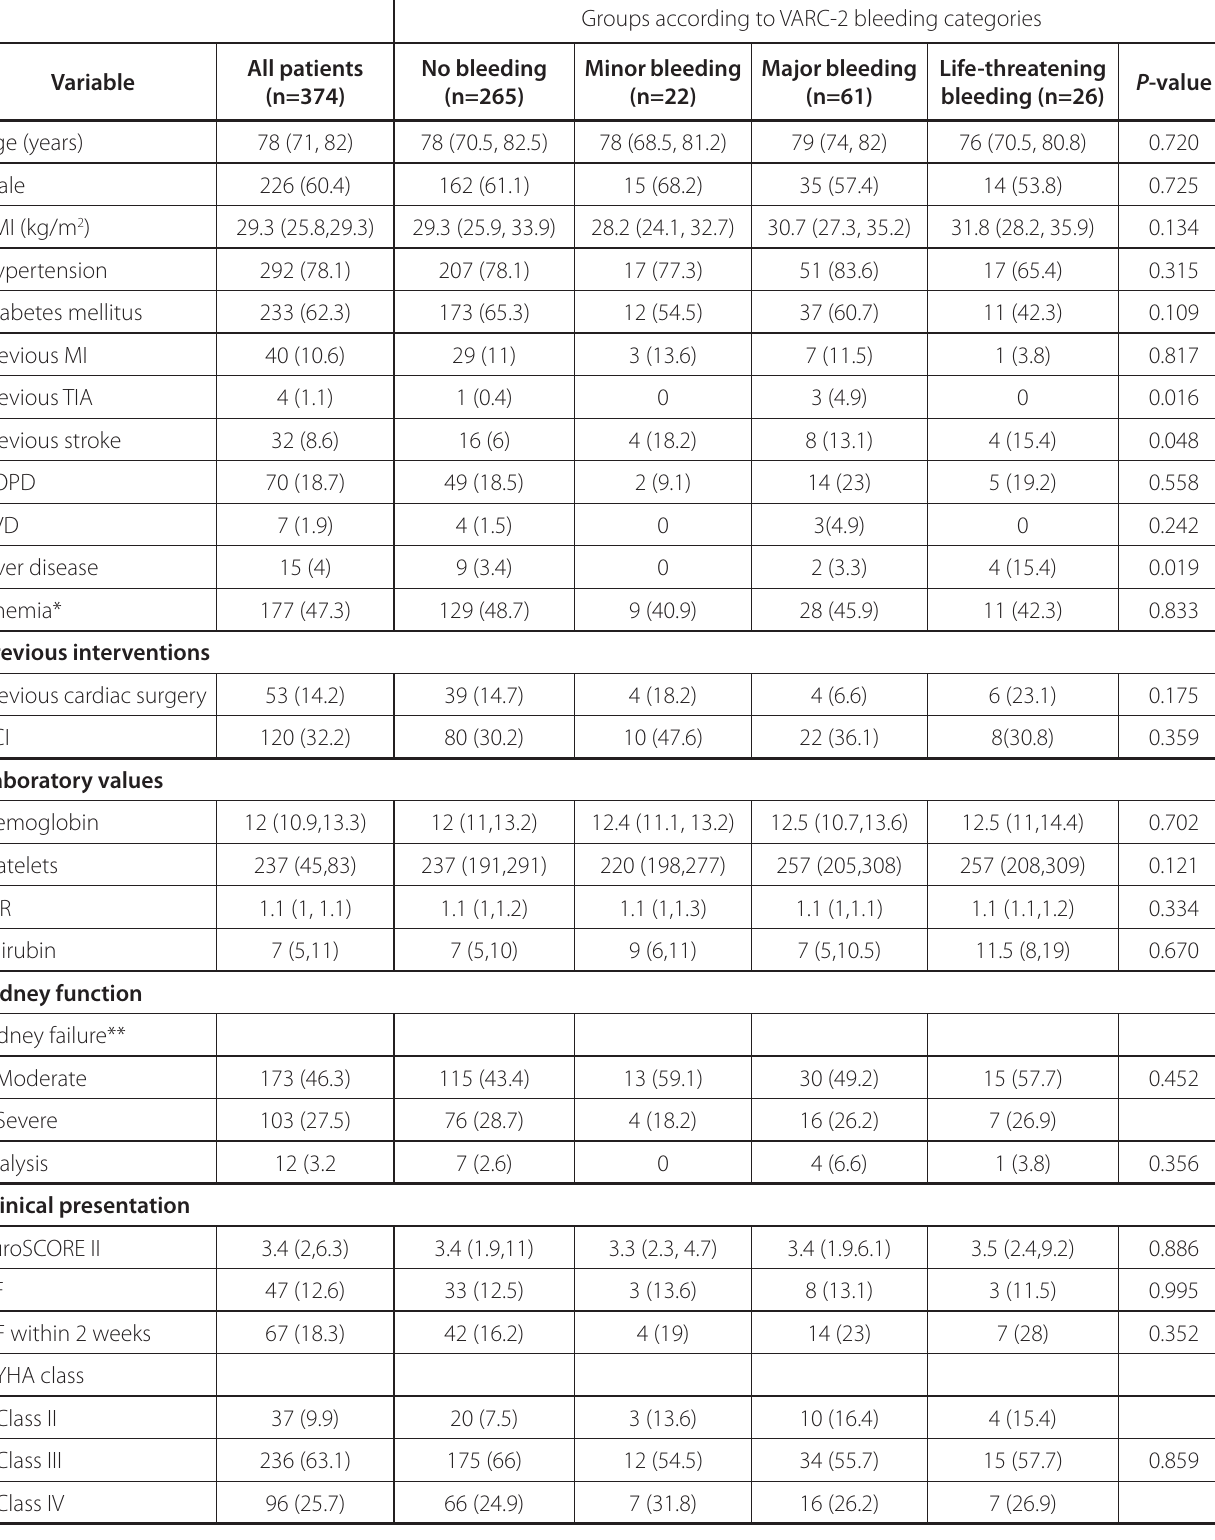
Table 1 . Baseline characteristics of patients. Continuous data were presented as median (25 th and 75 th percentiles) and categorical variables as numbers and